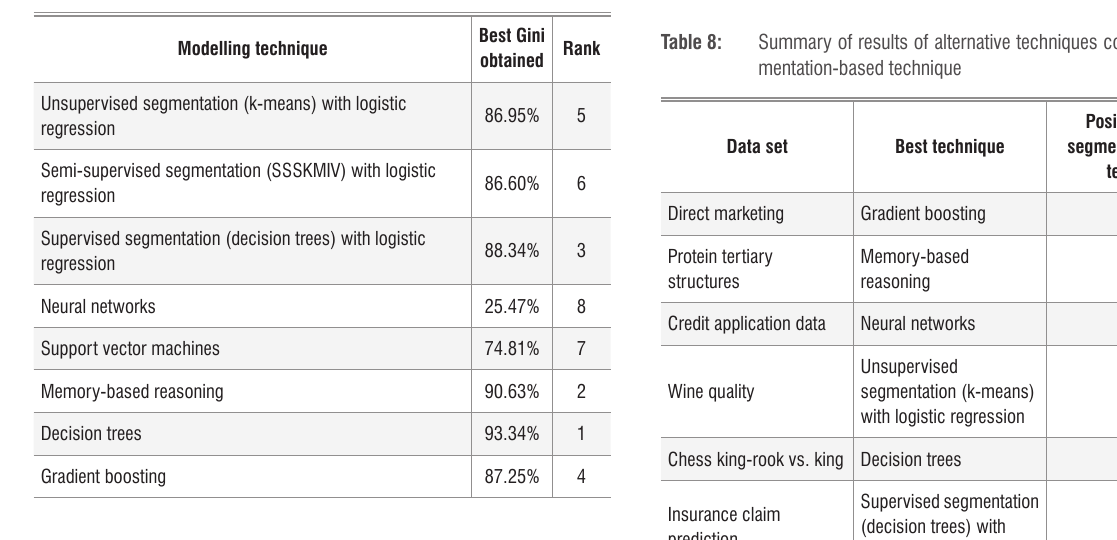
Table 6: Chess king-rook vs. king data set: Comparison of performance Modelling technique